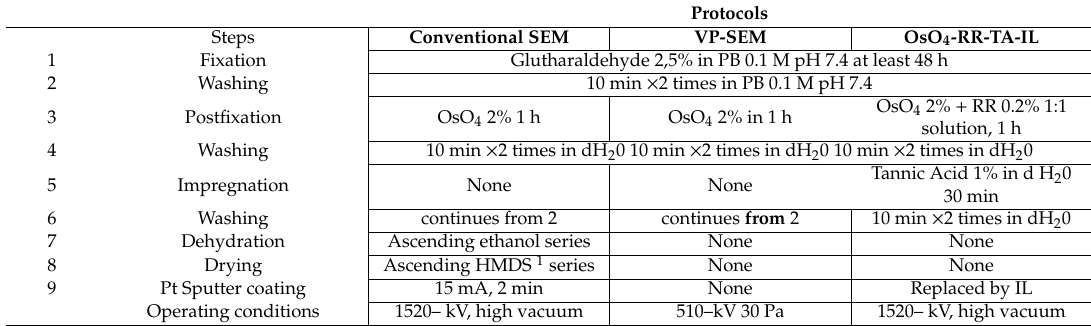
Table 1. Summary of di ff erent treatments steps and operating conditions of